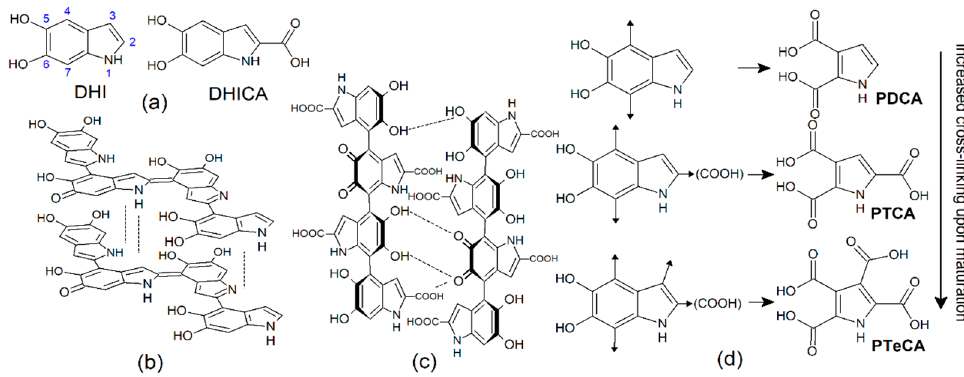
Figure 1. ( a ) Structures of DHI and DHICA, the two monomer units used to produce eumelanin, with IUPAC numbering scheme for indole units in blue. ( b ) Example of a eumelanin oligomer structure made solely from DHI, as proposed by d’Ischia et al., 2015, and Micillo et al., 2017, [3,16]. ( c ) Proposed structure [17] of a eumelanin polymer backbone made entirely from DHICA. Note that the ring system of each monomer unit is out of plane relative to the adjacent ones. ( d ) Various units in the proposed structure of DHI and DHICA eumelanins, together with the corresponding degradation products generated when these pigments are subjected to alkaline hydrogen peroxide oxidation (AHPO) (adapted from Ito et al., 2013, [18]).